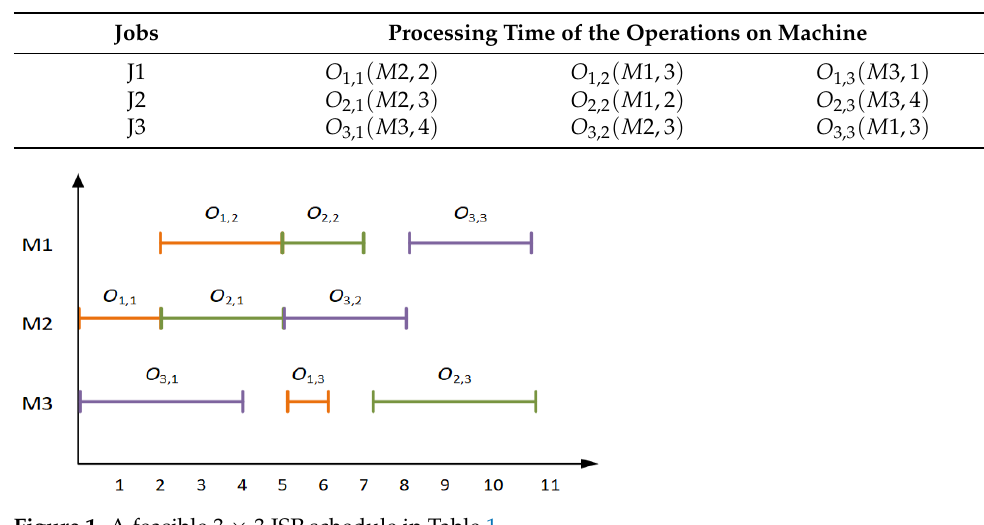
Figure 1. A feasible 3 × 3 JSP schedule in Table 1.